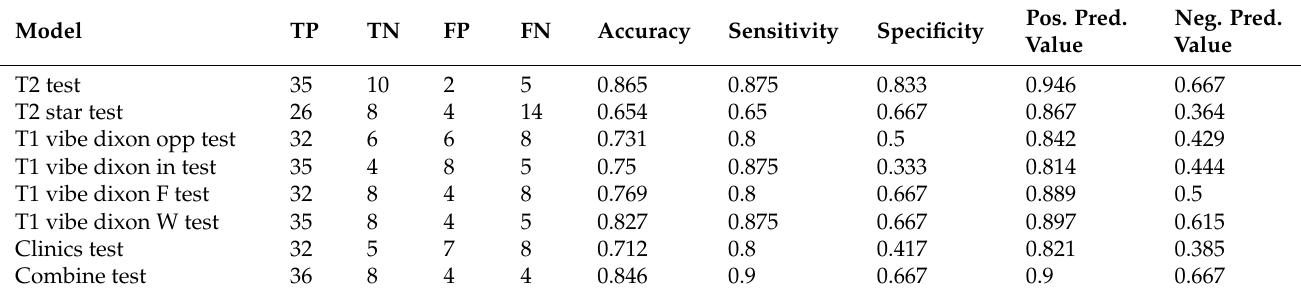
Table 4. Predictive efficacy of radiomics model, clinical model, and combined